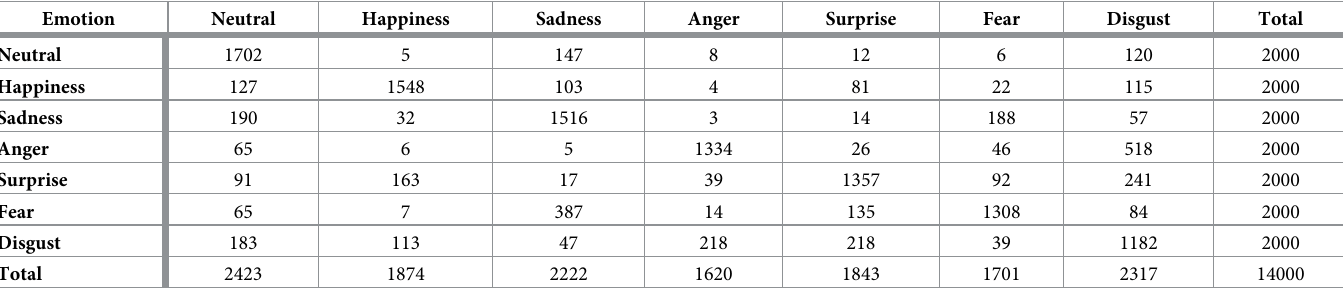
Rows represent rater-chosen emotions, columns represent speaker-acted